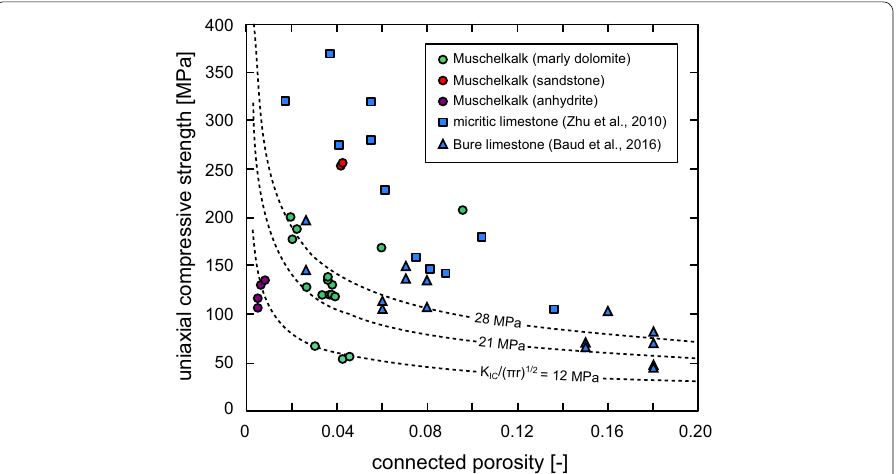
Fig. 9 Uniaxial compressive strength as a function of connected porosity for the studied Muschelkalk samples from exploration well EPS-1 (Soultz-sous-Forêts) and for published data for limestones from Zhu et al. (2010) and Baud et al. (2016). Three modelled curves are provided using the analytical solution of the Sammis and Ashby (1986) pore-emanating crack model provided by Zhu et al. (2010) (Eq. (1); see text for